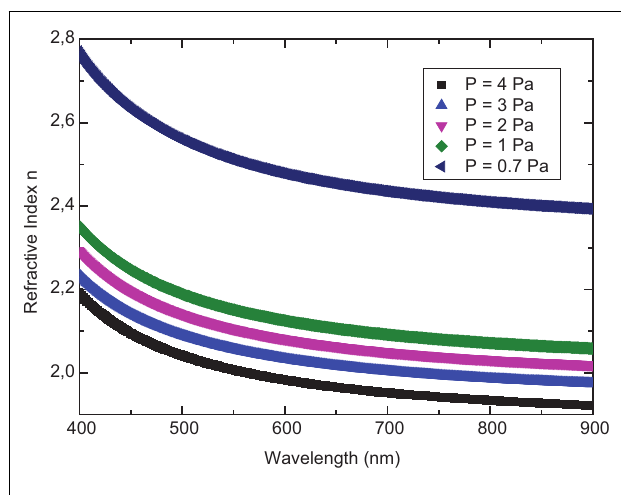
FIGURE 9 |The refractive index of theTiO 2 samples prepared at different sputtering pressures as a function of wavelength